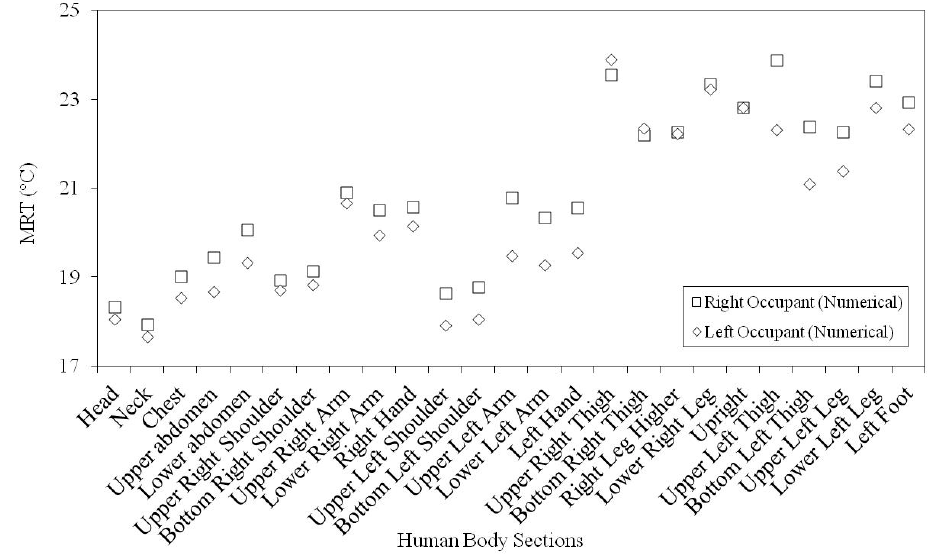
Figure 8. Numerical mean radiant temperature (MRT) values around the occupants seated on the right and left side are subjected. Table 4. Predicted mean vote (PMV) and percentage of dissatisfied people (PPD) indexes numerically calculated.